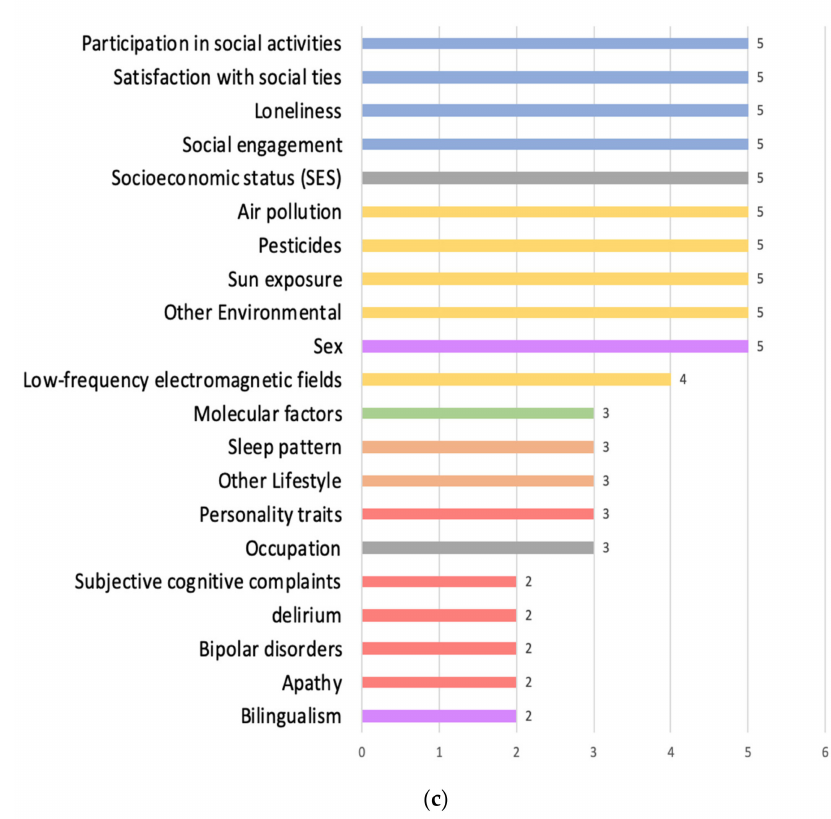
Figure 2. Frequency of reported factors grouped into subcategories ( a – c